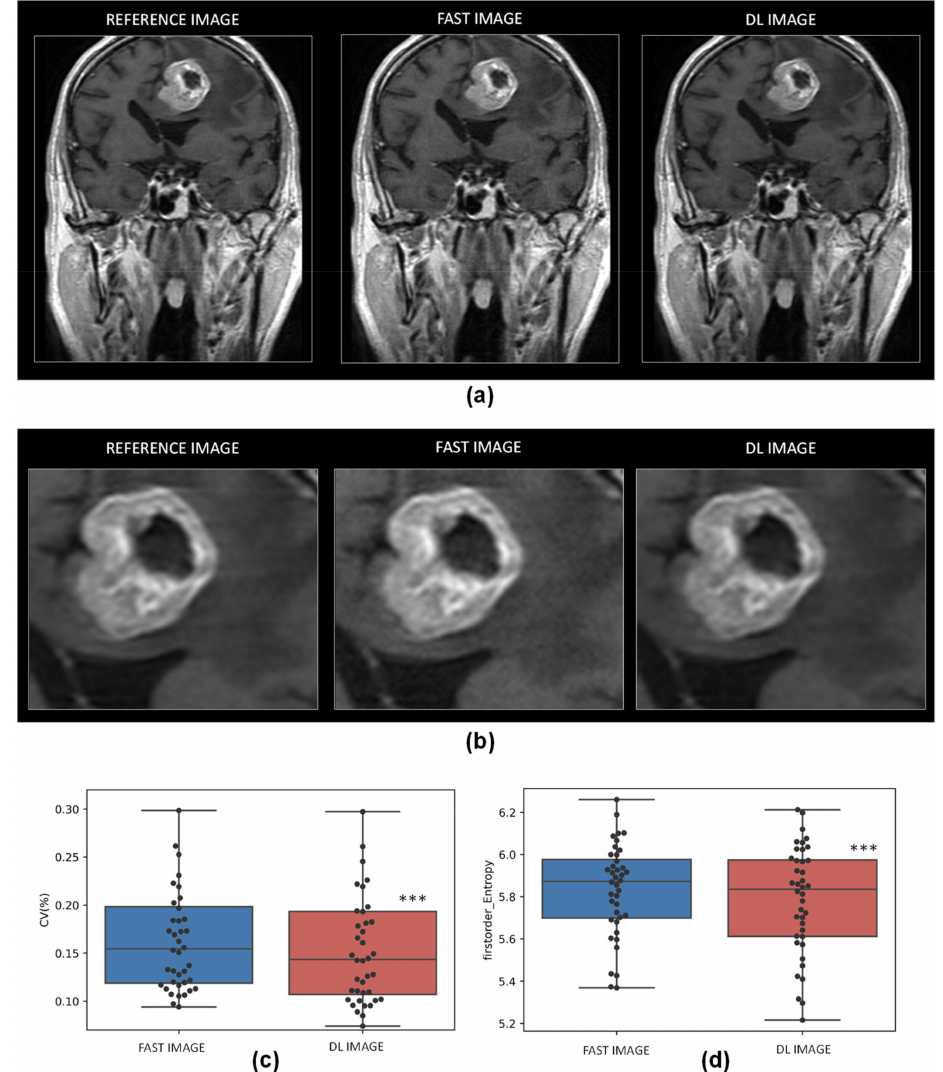
Figure 6. Denoising DL model. Representative MRI of reference images, fast acquisition images and DL reconstruction images in whole brain ( a ) and brain metastases ( b ). Quantitative analysis of the efficiency of the denoising DL model in brain metastases regions in comparison with fast images as evaluated by the coefficient of variation ( c ) and entropy ( d ) metrics. n = 40 for both groups, *** p < 0.001 vs. fast acquired